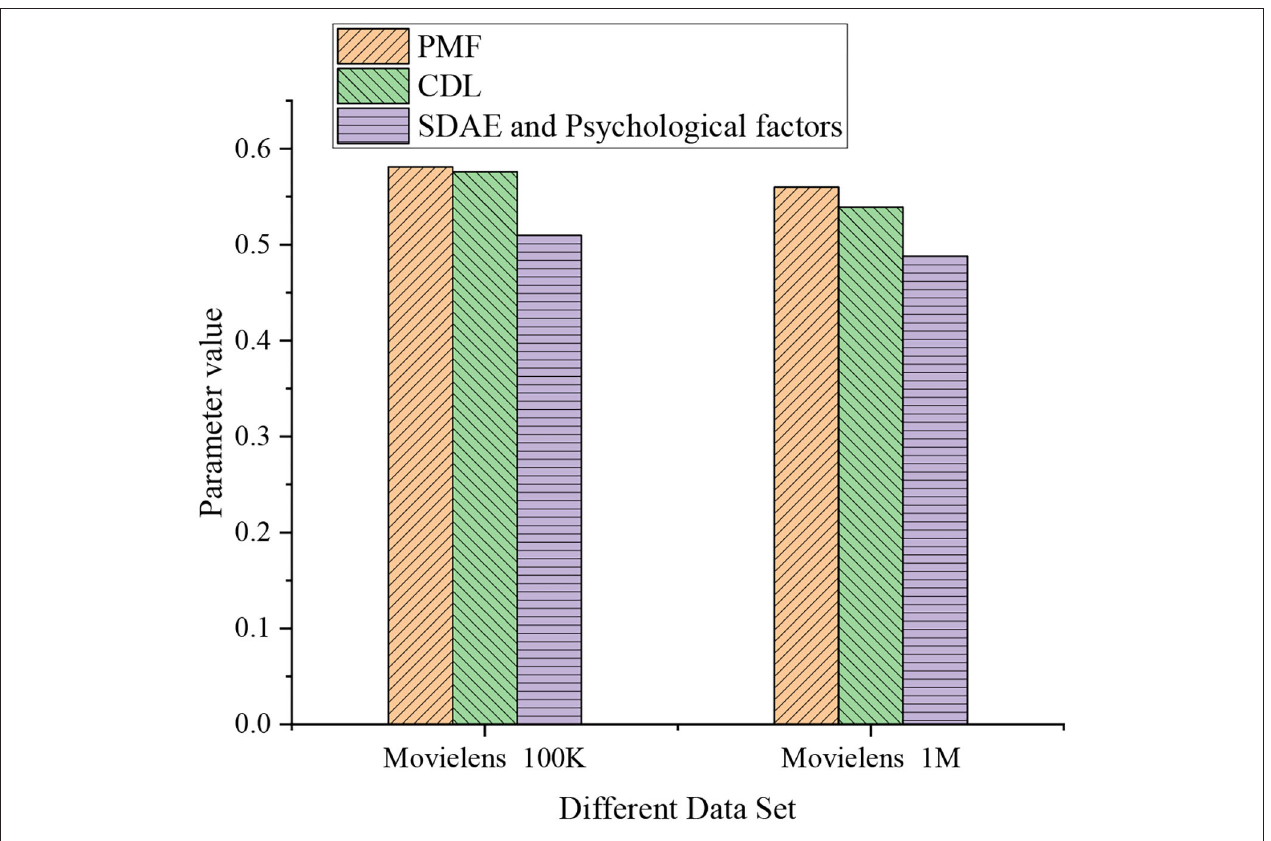
FIGURE 7 | Specific experimental results of different data sets.